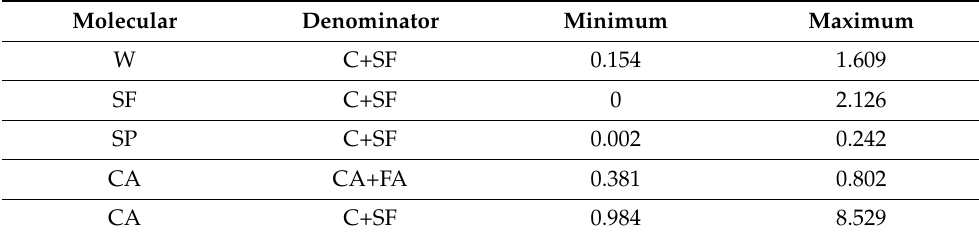
Table 3. Proportion relation of each